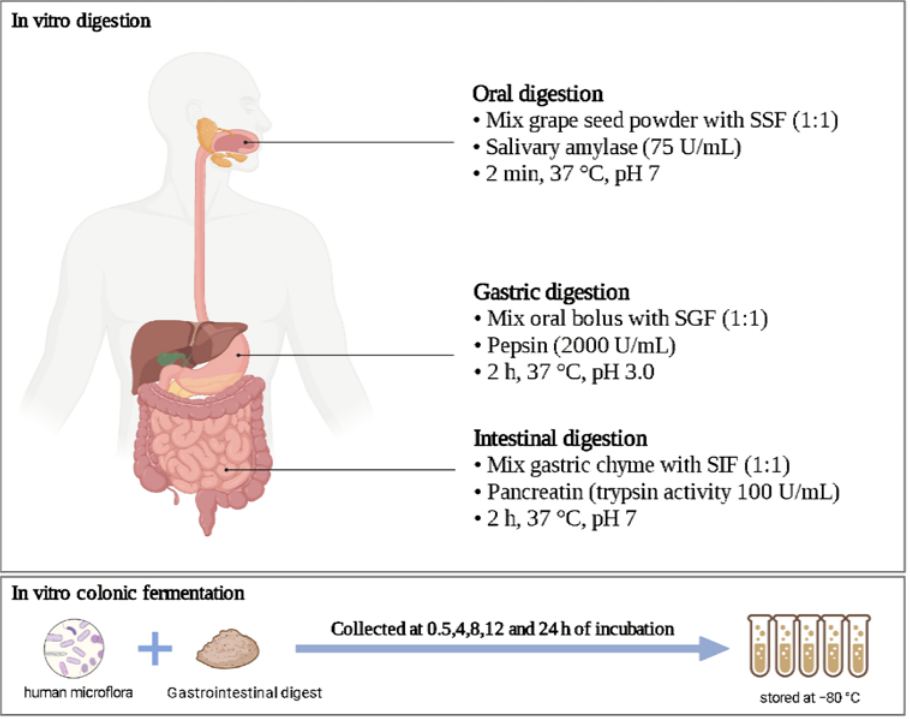
Figure 1. Diagram of VWS digestion and fermentation in vitro.